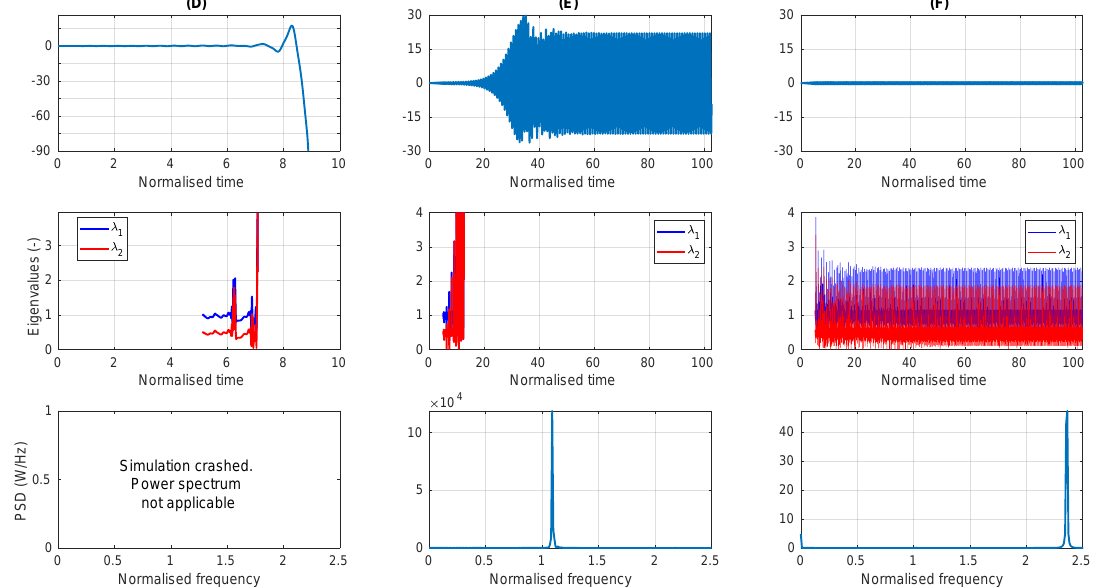
Figure 8. The pitch displacement time series ( top ), the magnitudes of the eigenvalues of the matrix A ( middle ) and the PSD of the pitch displacement ( bottom ), for the points (D) D, (E) E and (F) F in Figure